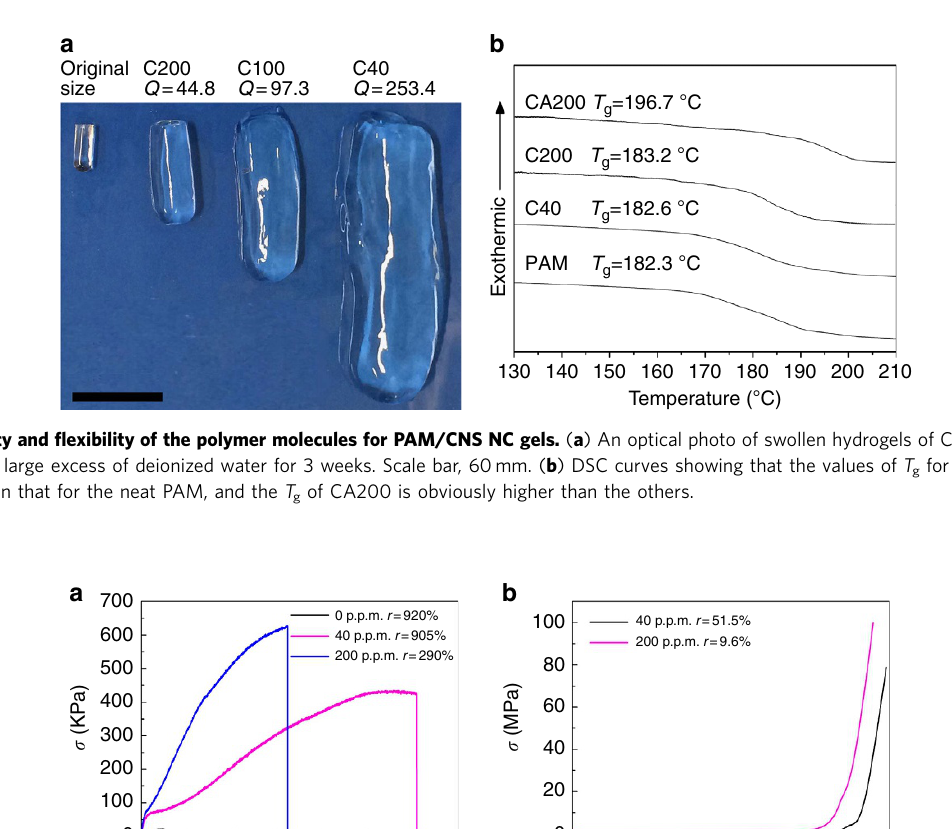
T g of the NC gels (C40: 182.6 (cid:2) C and C200: 183.2 (cid:2) C) are slightly higher than that of linear PAM (182.3 (cid:2) C) and almost